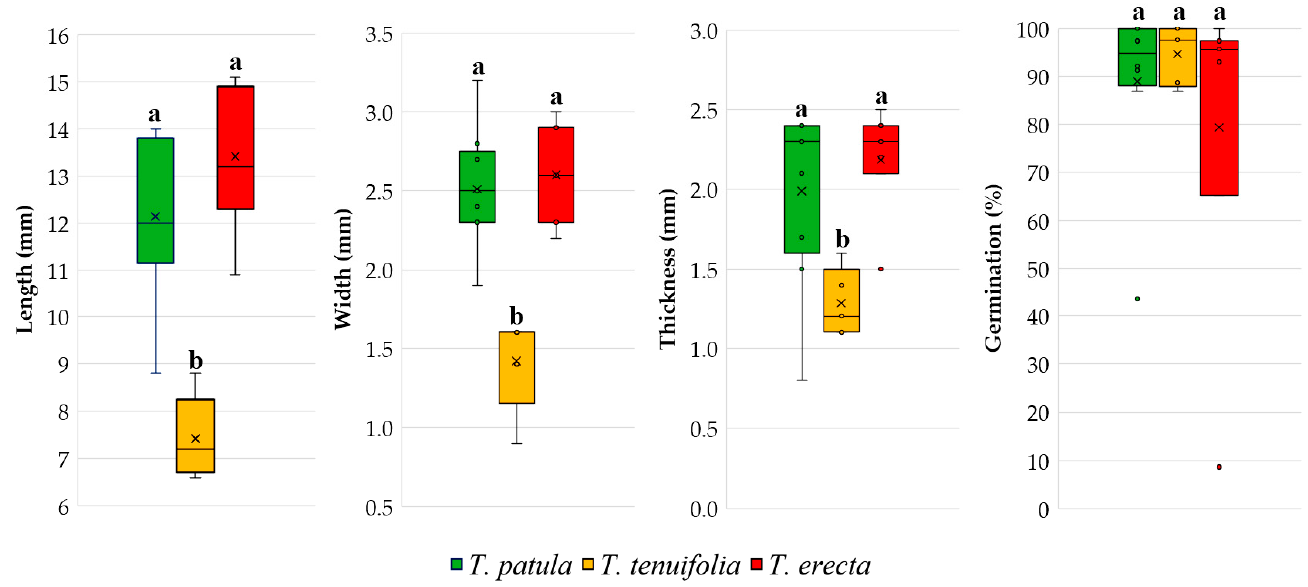
Figure 1. Main traits of the seeds based on the cultivars analysed in the three species of Tagetes . Each box plot represents minimum, lower quartile, median, upper quartile, and maximum values; in addition, the mean of the data is symbolised with a ‘ × ’ in the boxplot. Different letters among boxplots indicate statistically significant differences for the respective trait, at a significance level of p < 0.05 (Duncan